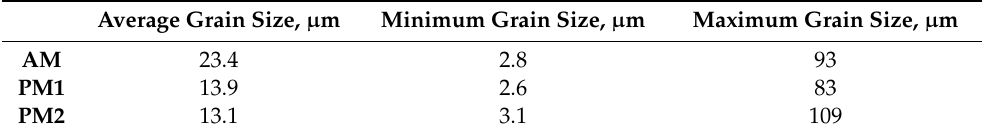
Figure 12. Comparison of the mechanical properties of the AM and PM specimens, I for PM1 and, II for PM2. 4. Conclusions It was demonstrated that laser powder bed fusion technology could be used to reduce the lead time in the manufacture of functional prototypes of PM components. To this end, FC-0208 steel powder was obtained by mixing ATOMET 1001HP iron powder with copper and graphite powders and heating this mixture up to a certain temperature to allow two phenomena to occur simultaneously: diffusion of carbon atoms into iron particles and metallurgical bonding of copper particles with iron particles. Next, a melt-pool analytical model was used to select the right set of